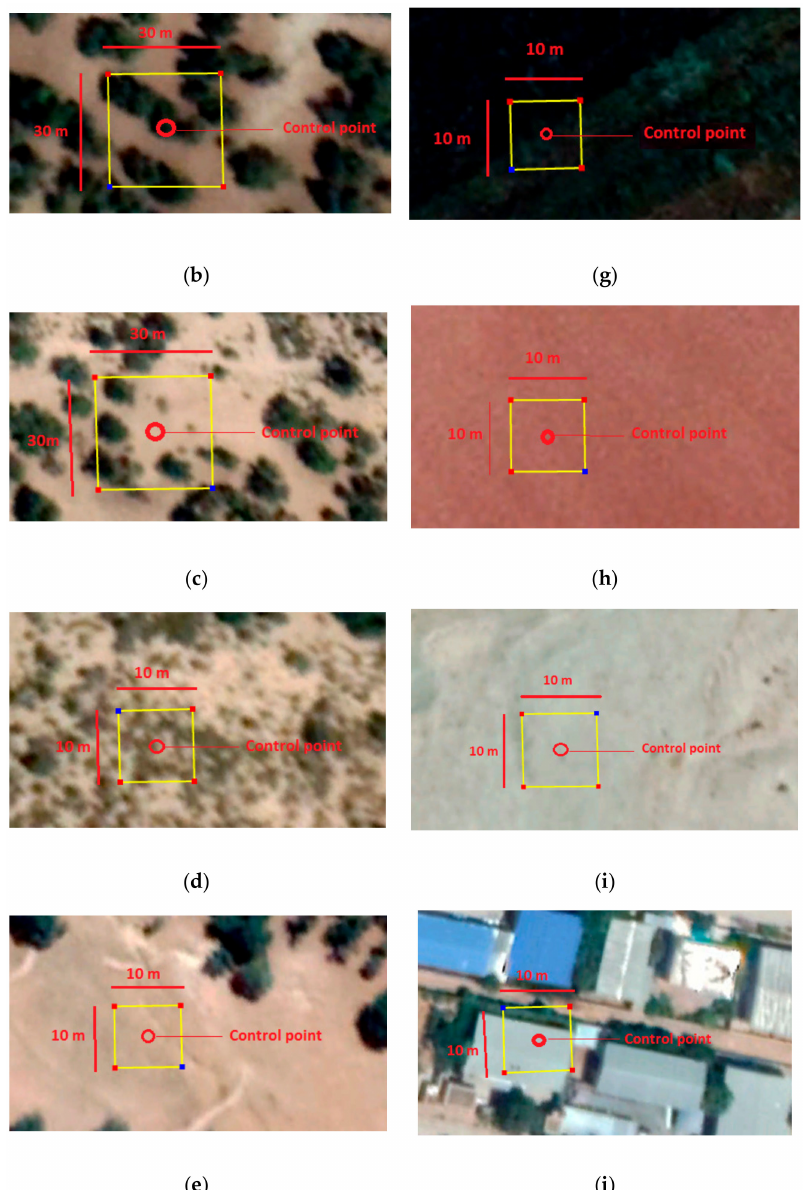
Figure 8. Di ff erent land cover plots in Google Earth used for the accuracy assessment of land cover maps. ( a ) Dense forest. ( b ) Semi-dense forest. ( c ) Sparse forest. ( d ) Dense rangeland. ( e ) Sparse rangeland. ( f ) Garden. ( g ) Irrigated farmland. ( h ) Dry farmland. ( i ) Bare soil. ( j ) Urban